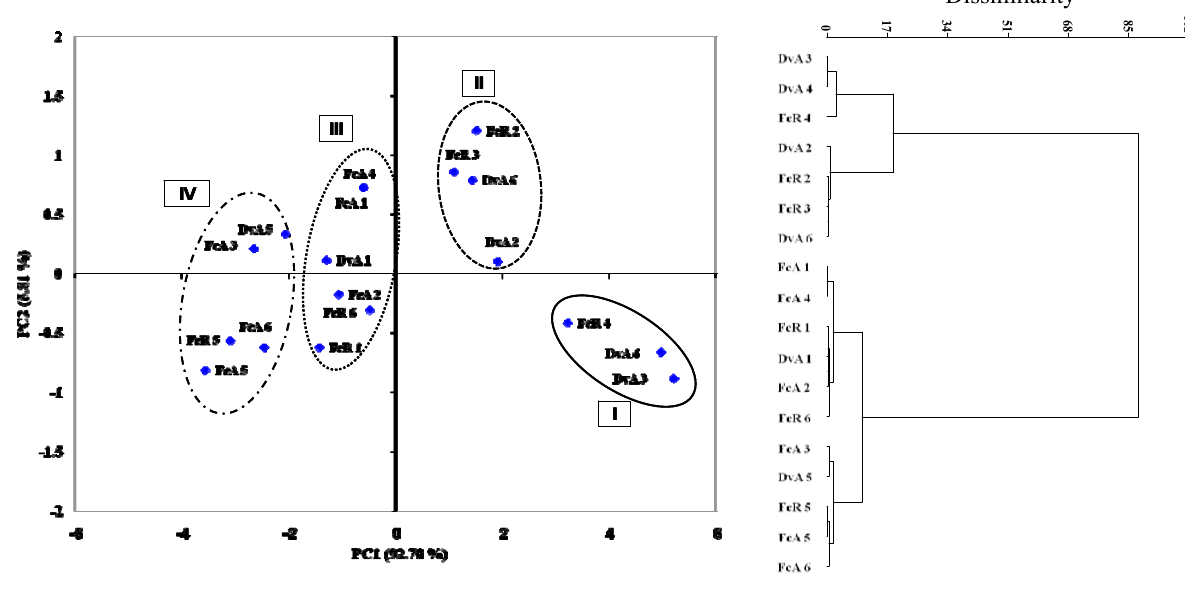
Figure 6. Classification of plant extracts according to colony growth of six postharvest fungi by PCA and cluster analysis. The percentage of total variance explained by each axis in PCA is shown. Numbers from 1 to 6, represent the pathogens Aspergillus spp.,